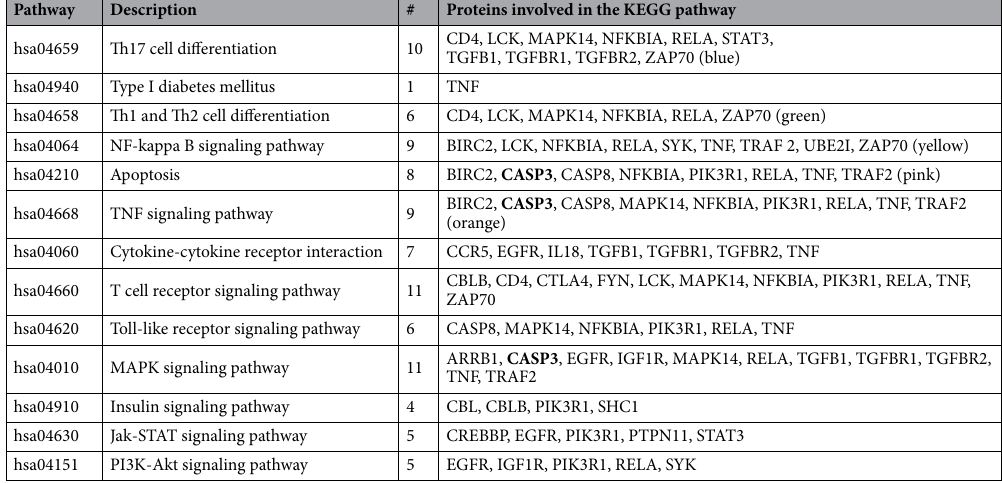
Table 3. The proteins of the backbone involved in the KEGG